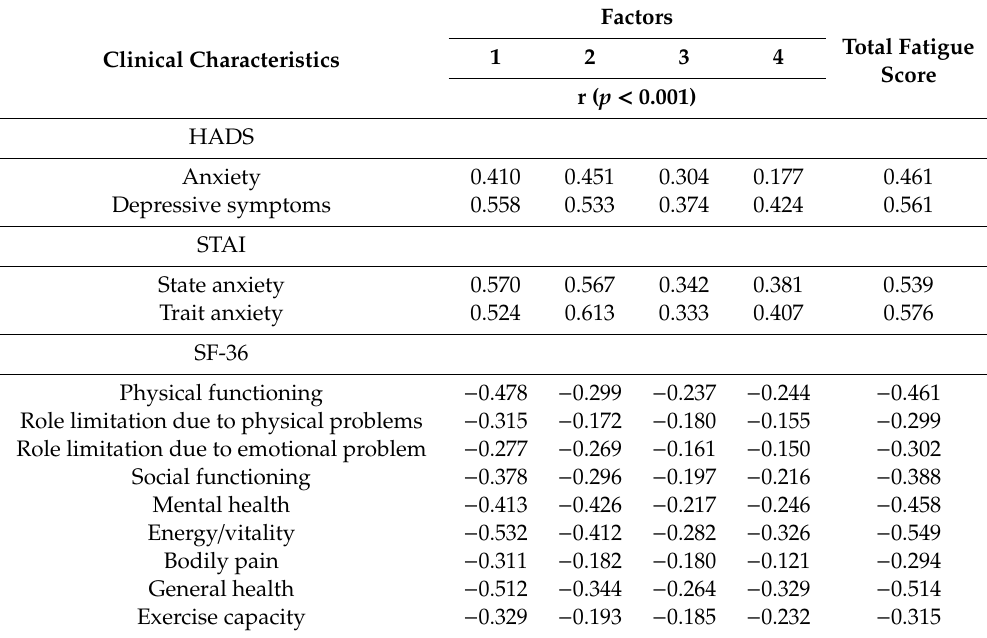
Table 7. Convergent validity: Pearson Correlation Coe ffi cients between the factors of Multidimensional Fatigue Inventory (MFI) 16—items, the HADS, the STAI, the SF-36, and exercise capacity in the overall